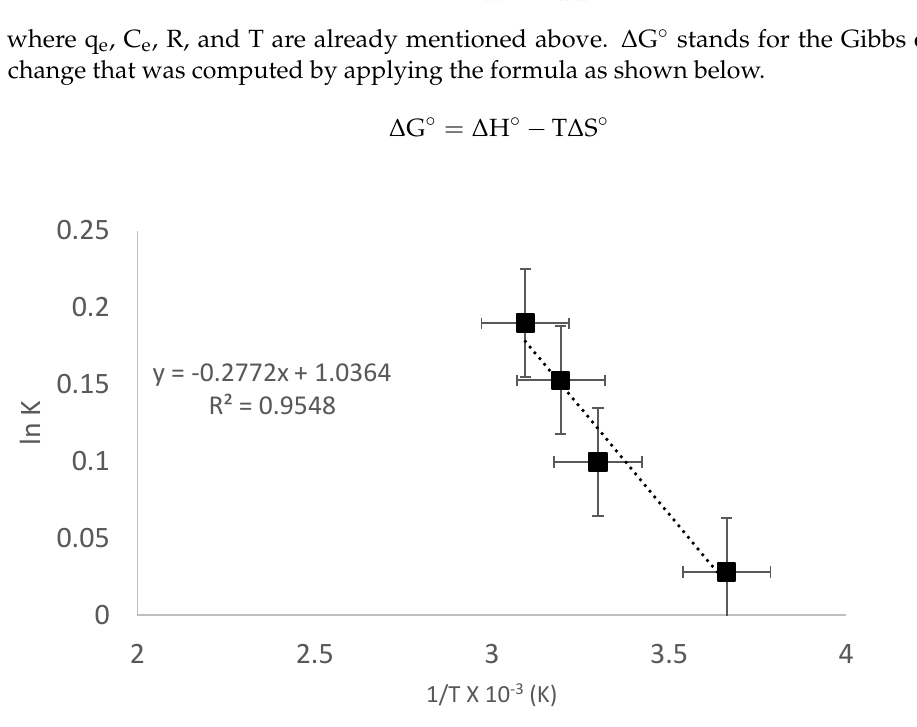
Figure 6. Thermodynamic plot of Zn (II) adsorption by CMPVL. Table 4. Thermodynamic parameters of Zn (II) biosorption on CMPVL.